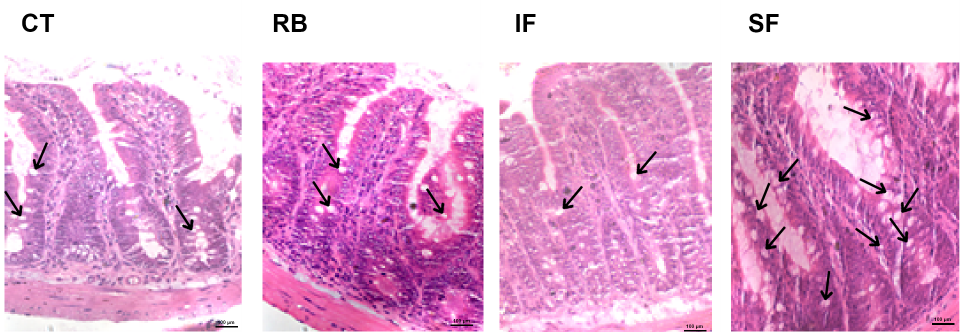
Figure 6. Light microscopic images (40 × magnification) of HE-stained ileum of mice in the treatment groups (CT = control, RB = rice beverage, IF = insoluble fraction, and SF = soluble fraction. Arrows indicate goblet